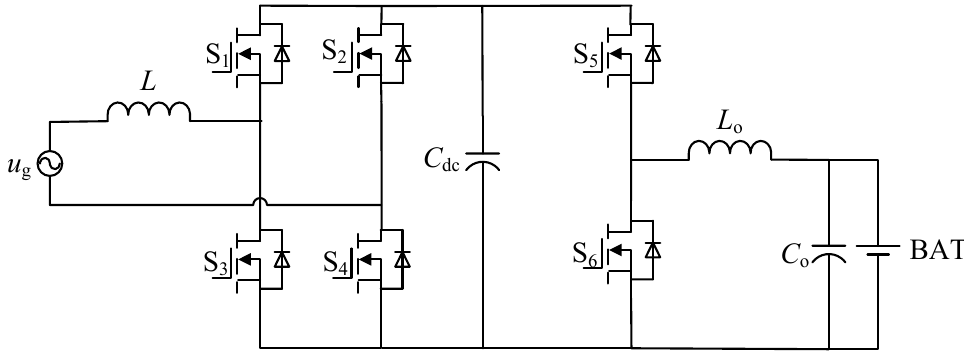
Figure 1. Topology of non-isolated on-board bidirectional charger composed of pulse